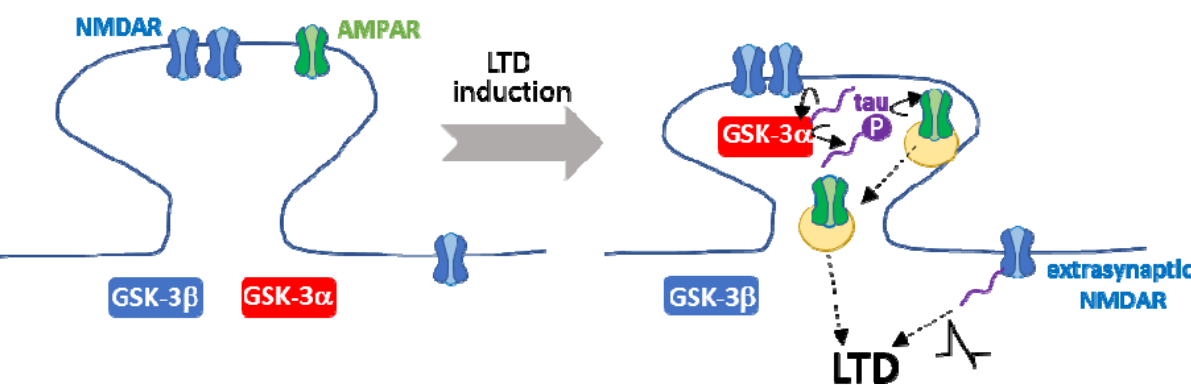
Figure 4. Interplay between GSK-3 α and tau during NMDAR-mediated LTD. Tau is required for the transient anchoring of GSK-3 α at dendritic spines, a key process during NMDAR-mediated LTD. On the other hand, GSK-3-mediated phos- phorylation of tau in Ser 396 is necessary for LTD. Tau contributes further to other crucial aspects of LTD, such as the internalization of AMPAR and NMDAR extrasynaptic currents. It is still controversial whether tau is upstream and/or downstream of GSK-3 α in